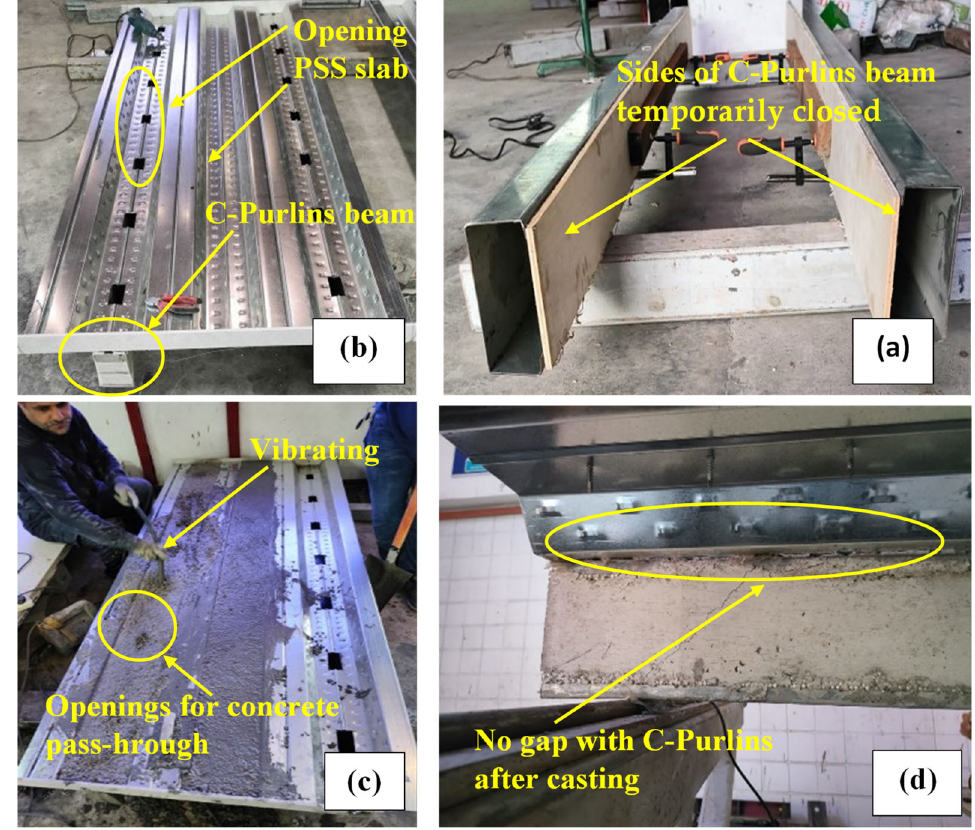
Figure 4. Pouring the concrete inside the CBPDS specimens; ( a )cover the C-Purlins sides, ( b ) provide openings, ( c ) pouring the concrete with vibrating, and ( d ) No concrete gap.